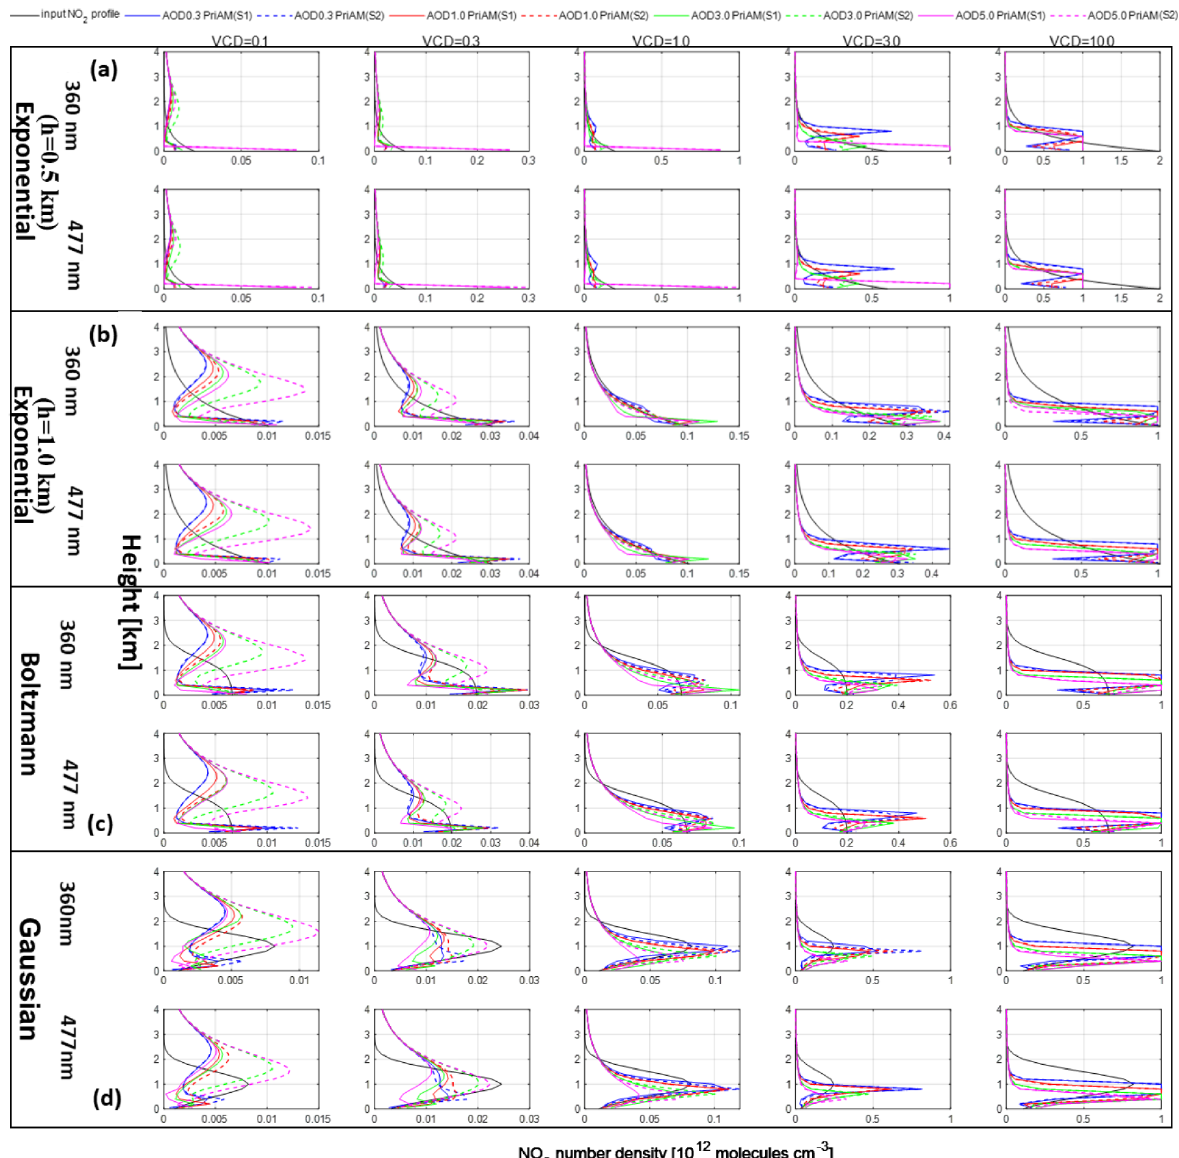
Figure 13. Retrieved NO 2 profiles by PriAM for scenarios S1 and S2 and input NO 2 profiles for four AODs (0.3, 1.0, 3.0, and 5.0) and five VCDs for (a) exponential shape with h = 0.5km, (b) exponential shape with h = 1.0km, (c) Boltzmann shape, and (d) Gaussian shape. The first line in each panel denotes the results for 360nm, and the second line denotes the results for 477nm. The solid and dotted colored lines refer to the AODs and strategies shown at the